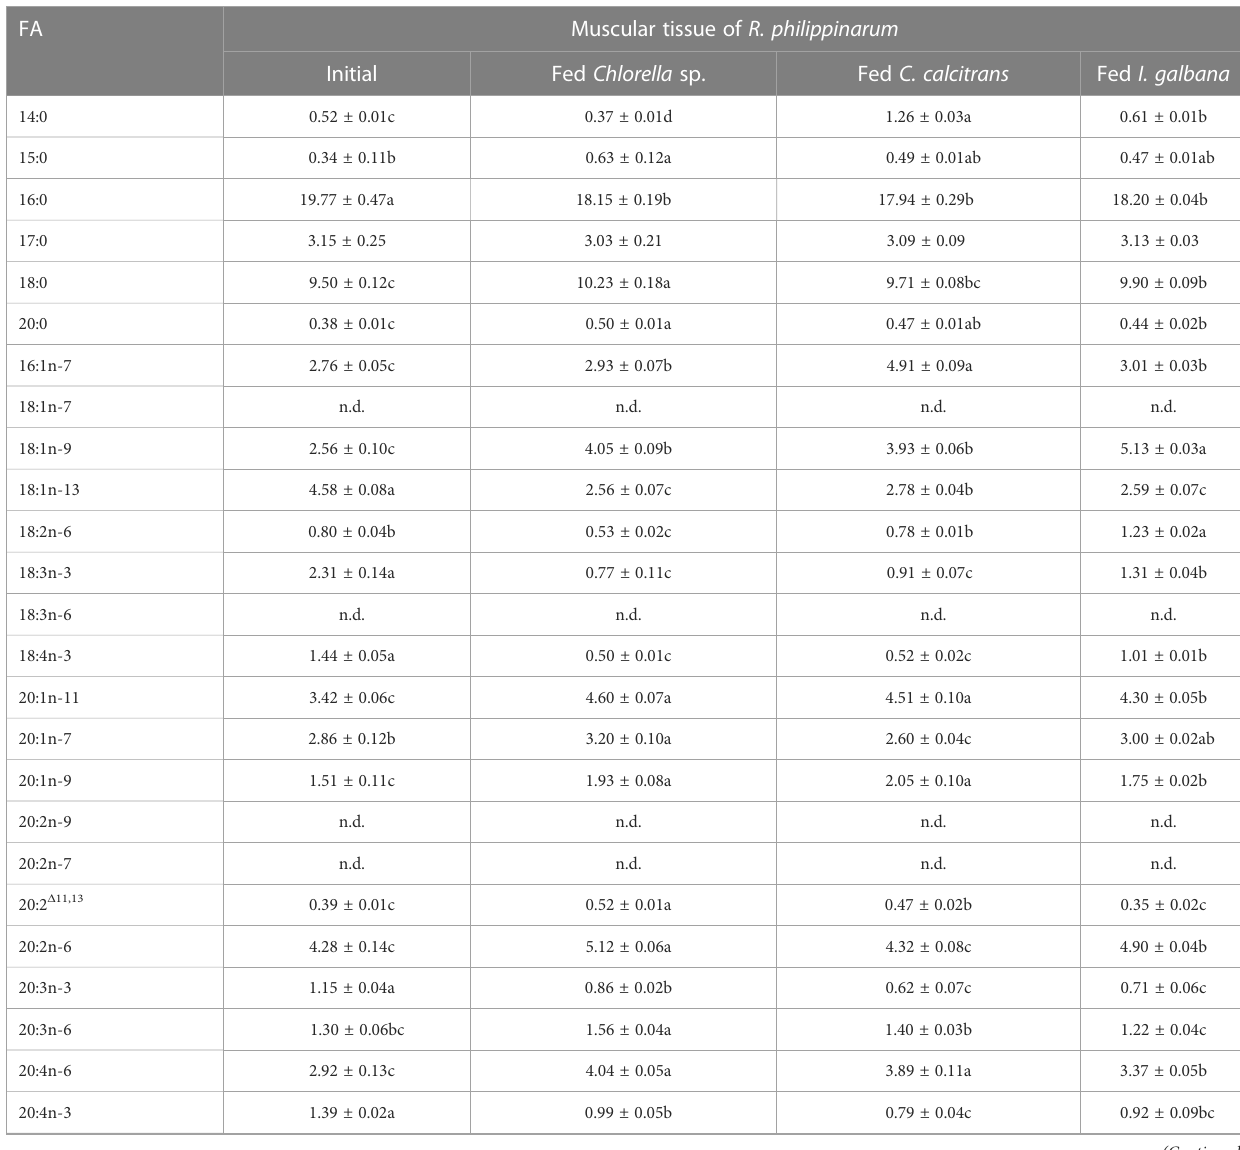
TABLE 2 Fatty acids composition (%) in muscular tissue of R. philippinarum fed with microalgae diets varied in LC-PUFA composition before and after the experiment. FA Muscular tissue of R. philippinarum Initial Fed Chlorella